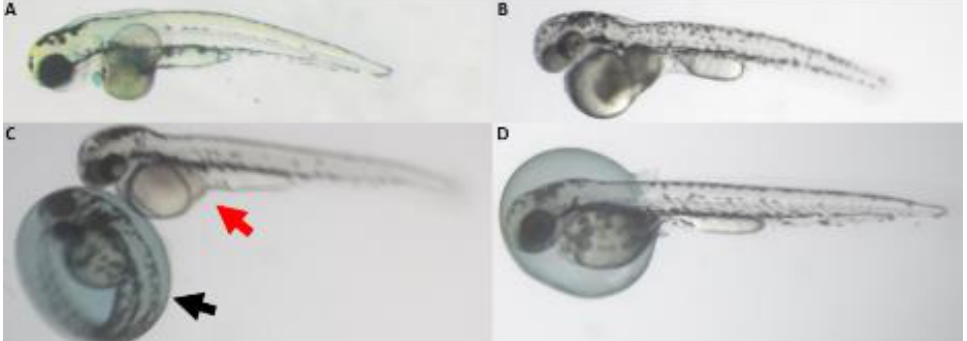
Figure 5. Brilliant Blue treatment weakened the zebrafish embryonic yolk sac. Hatched embryos (( A – C ) red arrow) had their yolk sac ruptured, while unhatched embryos remained intact (( C ) black arrow). During hatching ( D ), the chorion injured the softened yolk, causing its rupture and finally killing the larva. Images were taken at 2-dpf and 5 g/L BB.